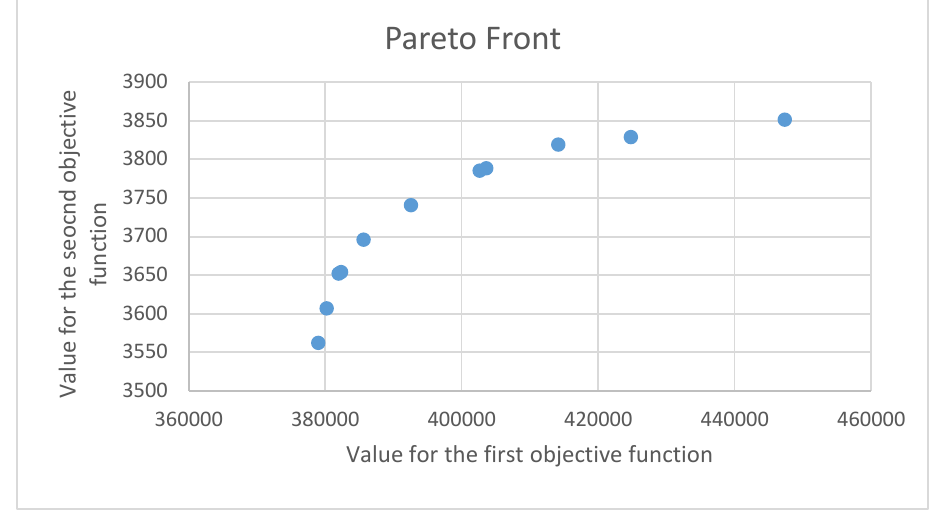
Figure 2. Pareto frontier for the